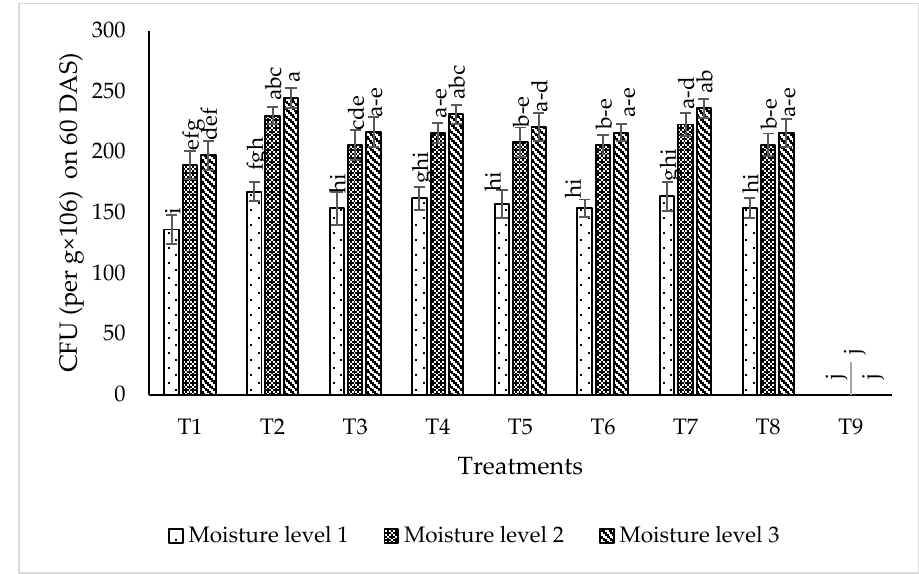
Figure 9. Survival of isolates Colony Forming Unit (CFU/g × 10 6 ) in rhizospheric soil 60 days after sowing (DAS) at different moisture levels in glass house experiment. The bars indicate standard error (±SE) of the mean ( n = 3). Means followed by the same letter within the bars are not significantly different at p = 0.05. T1 = RZ22 + RP01 + RS15, T2 = RZ11 + RP01 + RS14, T3 = RZ11 + RP08 + RS14, T4 = RZ11 + RP08 + RS15, T5 = RZ11 + RP01 + RS15,T6 = RZ22 + RP08 + RS14, T7 = RZ22 + RP08 + RS15, T8 = RZ22 + RP01 + RS14, T9 = control, where RZ11 = Mesorhizobium ciceri , RP08 = Enterobacter cloacae , RS14 = Bacillus mojavensis , RS15 = Providencia vermicola , RP01 = Bacillus subtilis , RZ22 = Mesorhizobium ciceri , Moisture level 1 = 55% of Field Capacity, Moisture level 2 = 75% of Field Capacity, Moisture level 3 = 95% of Field Capacity.